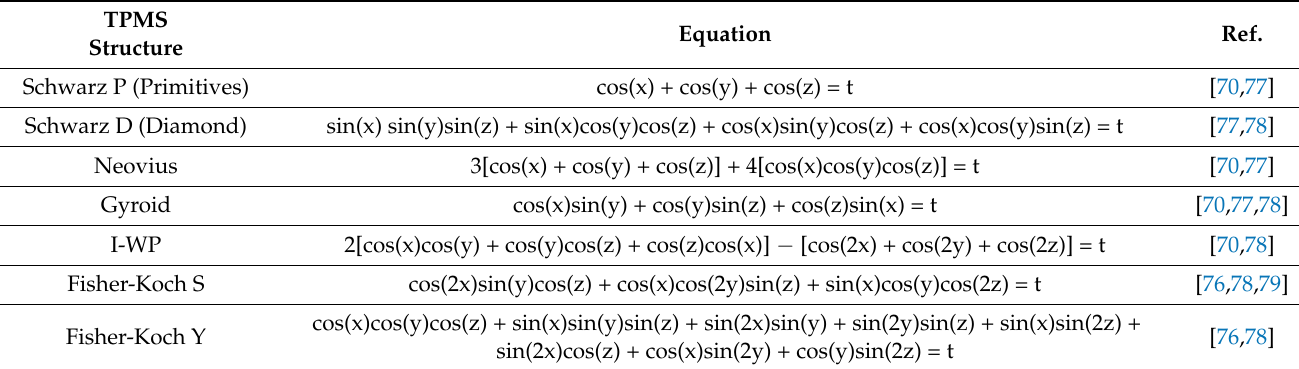
Table 3. Mathematical Equations of Triply Periodic Minimal Surfaces (TPMS)